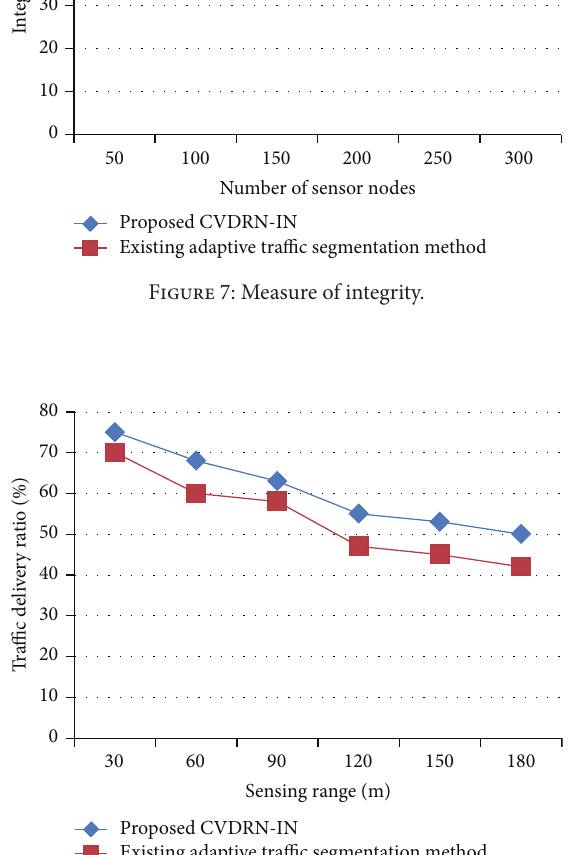
Figure 8: Measure of traffic delivery